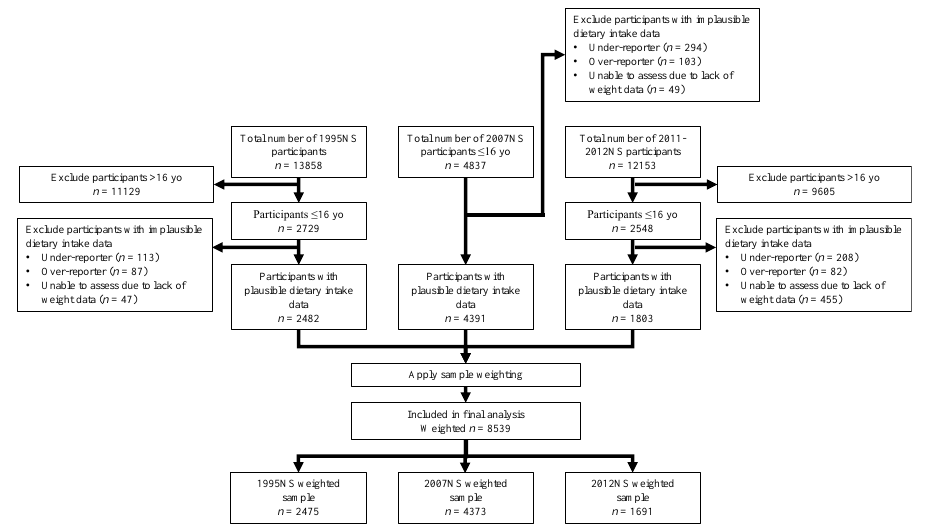
Figure A1. Flow of participants.